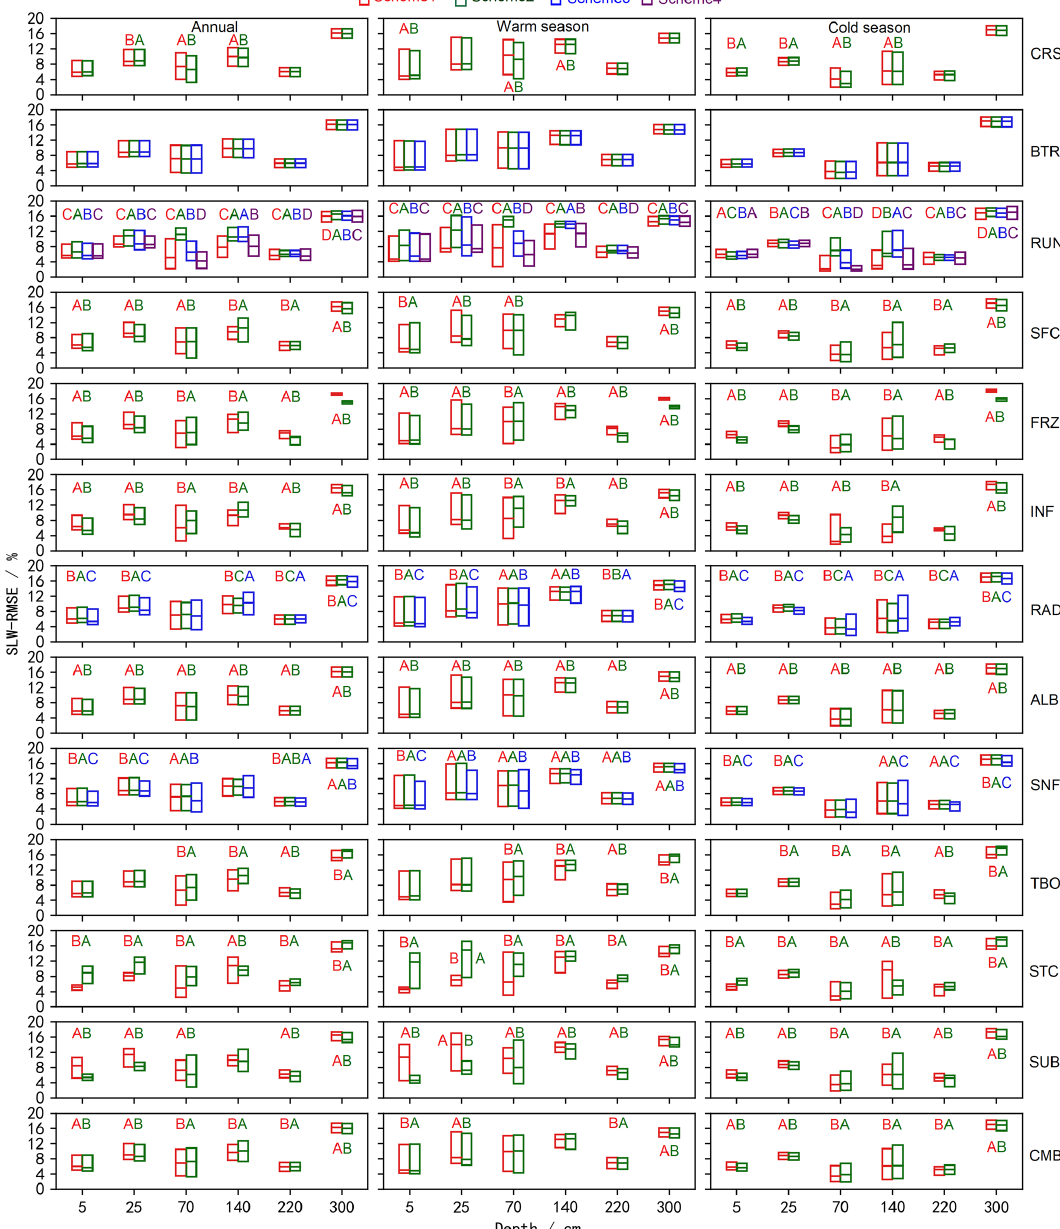
Figure 8. Same as in Fig. 7 but for